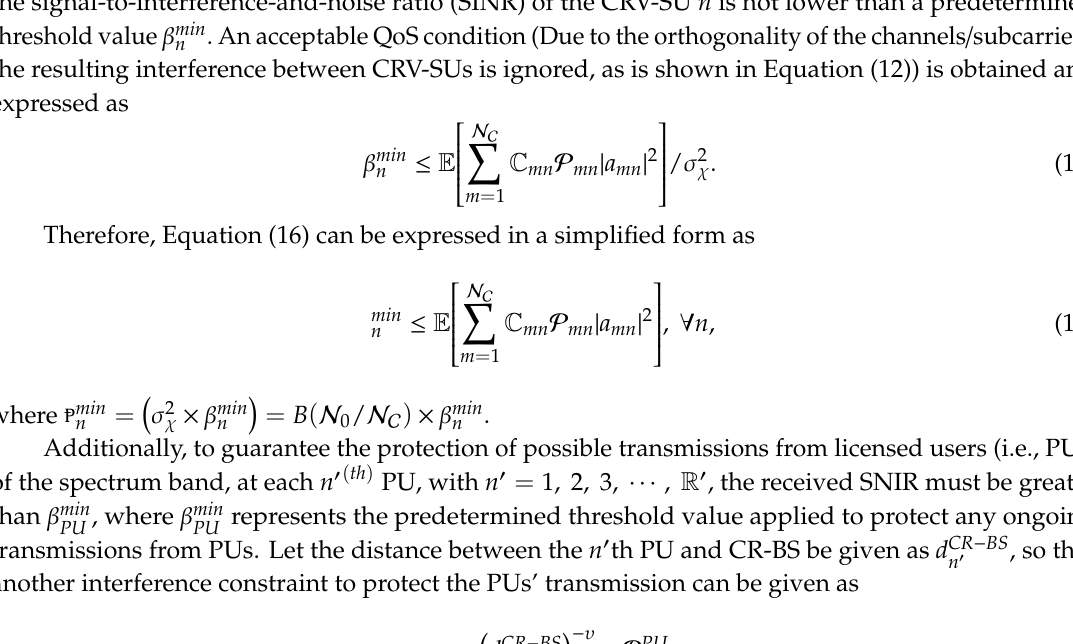
Table 2. List of acronyms.